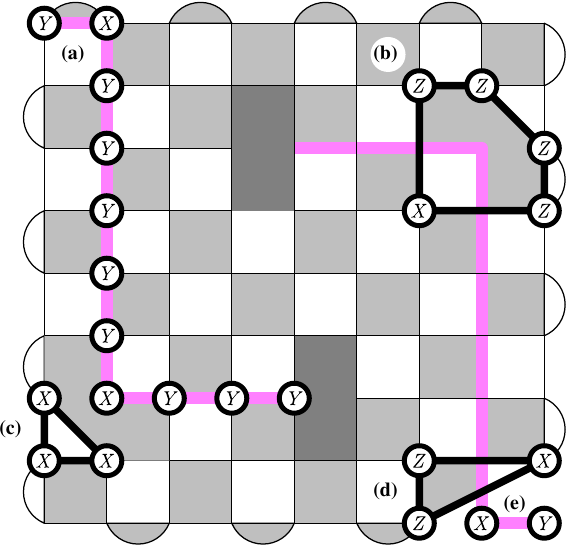
FIG. 6. Moving the twist defects at the corners of the planar code into the bulk of the lattice. (a) We make single-qubit Pauli measurements along the pink defect line to deform the twist defect from the corner of the planar code to the center of the lattice. Most of the measurements along the line are Pauli- Y operators, but we also use Pauli- X measurements and Pauli- Z measurements to move a twist around a corner. (b,c) Stabilizer operators that are modified by the code deformation at locations where twists are moved around corners. (d) The stabilizer operator that lies at the corner of the lattice where a twist defect has been removed. (e) Two qubits at the corner of the lattice that have been measured in a product basis and are no longer entangled with the